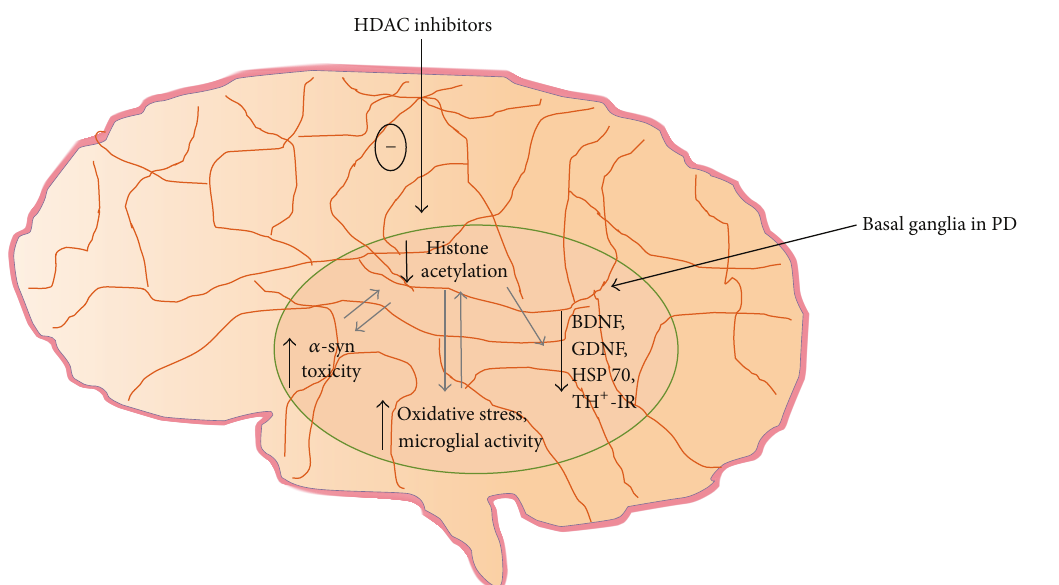
Figure 4: Neuroprotective mechanisms exerted by HDAC inhibitors. HSP 70: heat shock protein 70, BDNF: brain derived neu- rotropic factor, GDNF: glial cell derived neurotropic factor, 𝛼 -syn: alpha-synuclein, and TH + -IR: tyrosine hydroxylase immunoreactiv-